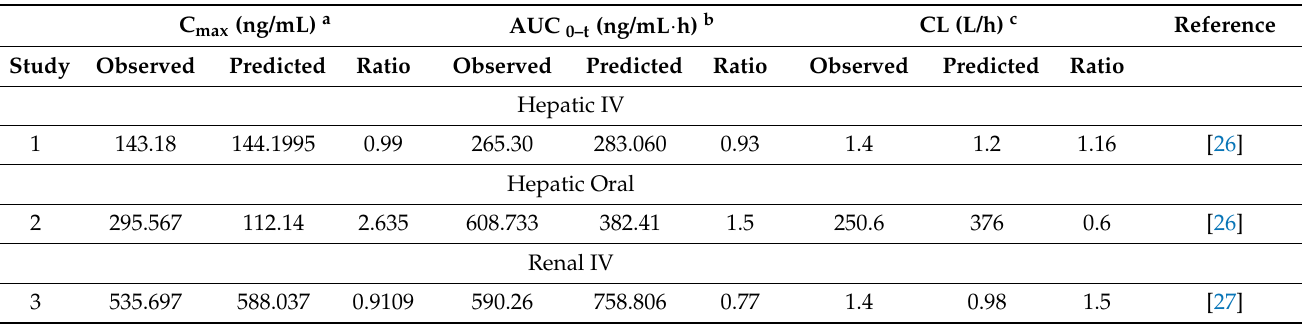
Table 4. Observed and predicted values of various PK parameters and their respective R values in a diseased